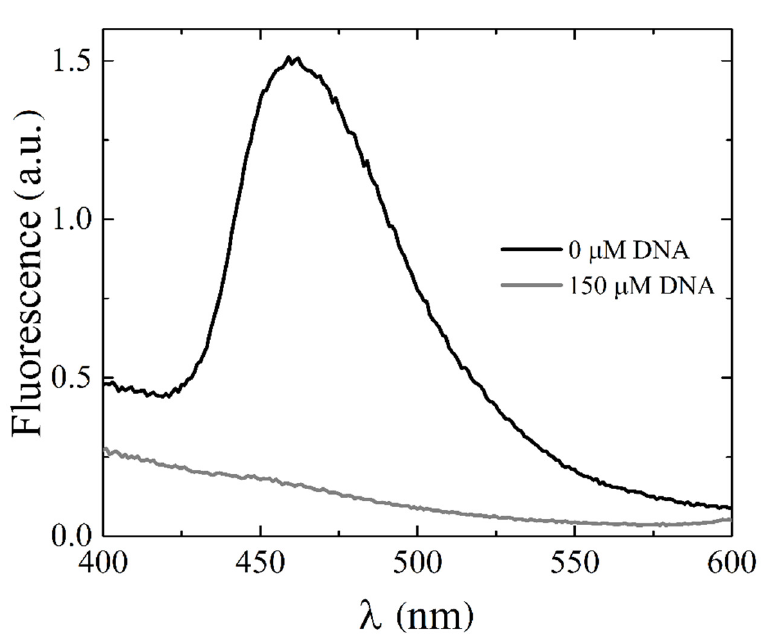
Figure S6b, for the spectrum detected on the samples added with 1 dissolved in DMSO and DMF, respectively.